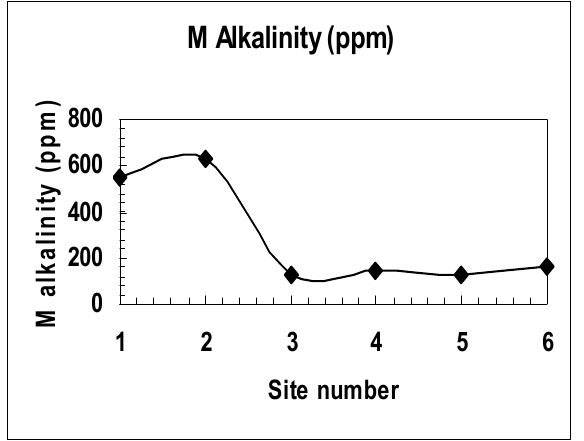
Figure 5: Variation of M alkalinity with the site number. The line-diamonds are the experimental data.